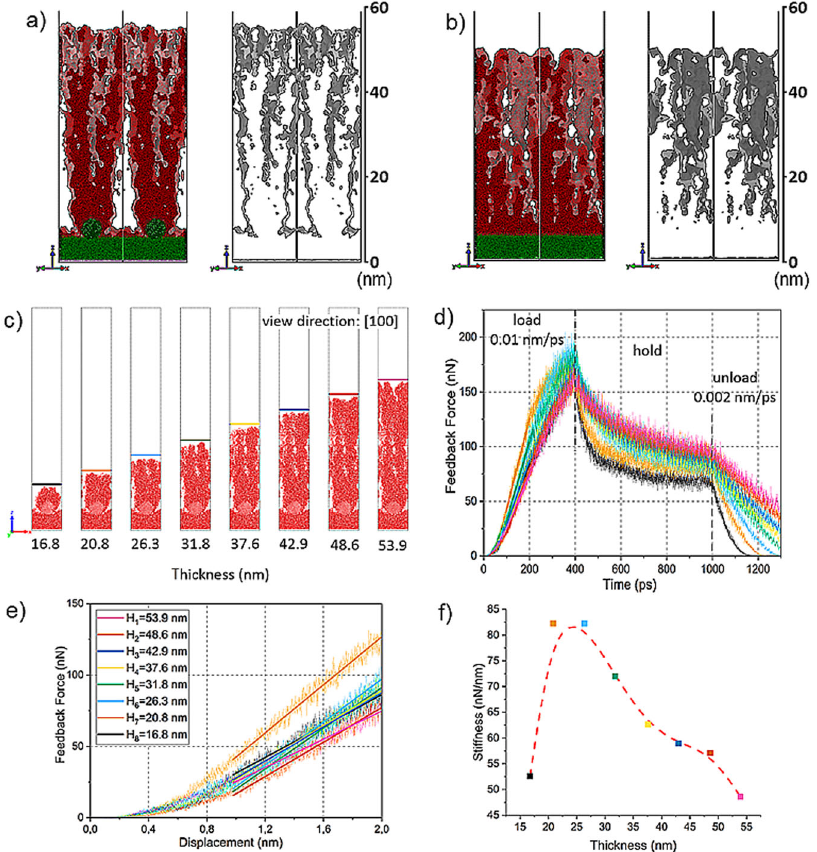
Fig. 4 Correlation between morphology and mechanical properties by MD simulations. a Silicon deposited on a NP (duplicated along the (100) direction, due to periodic boundary conditions) at 500 K follows columnar growth and forms a vaulted structure. The simulation box, sliced for clear observation, is viewed along the (110) direction. The right panel only depicts the sliced surface mesh inside the deposited layer (i.e., without the atoms), indicating the presence of voids. b Same but without the NP. A sedimentary structure forms from the start of the deposition, also leading to extensive voids throughout. c Eight instances with NPs selected from the growth simulations, sliced and viewed along the (100) direction. d Evolution of the force – depth curve; a compress – hold – decompress loop was performed with a fl at-diamond carbon tip at 500 K. e Initial linear elastic deformation within displacements of 2 nm, with linear regression fi tting (solid lines). f Stiffness of the corresponding structures as a function of thickness, clearly demonstrating the rigidity of the vaulted